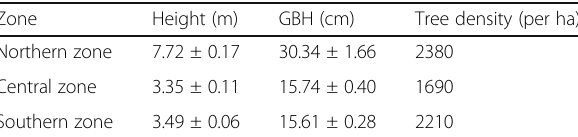
Table 3 Soil organic carbon stock in each